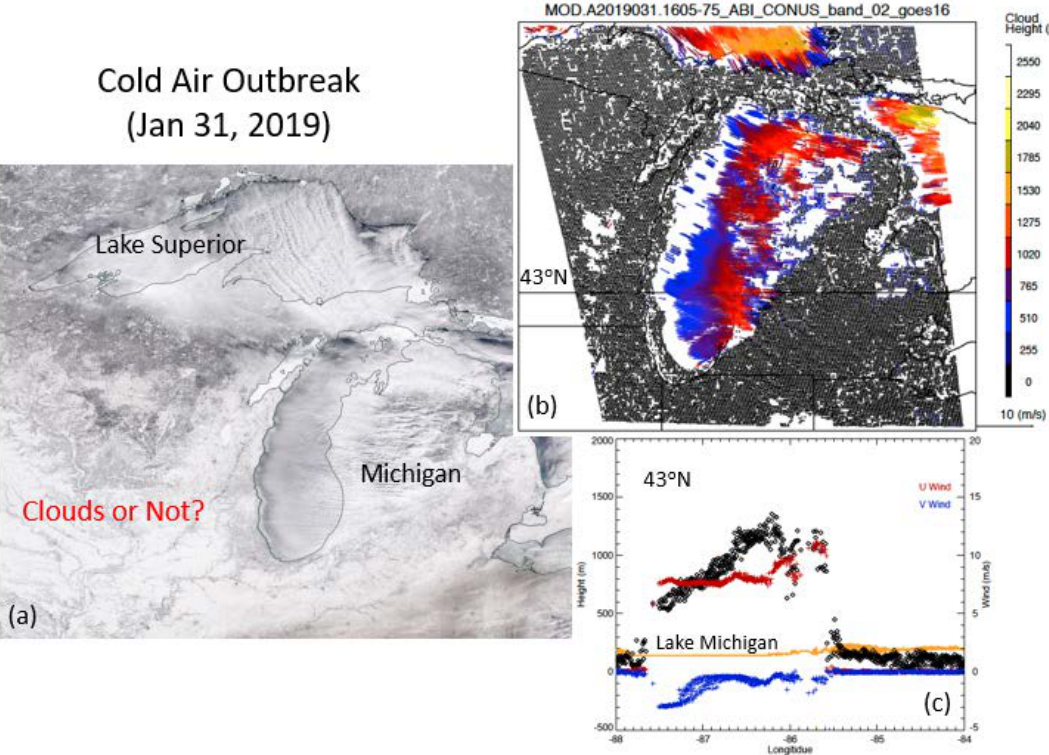
Figure 25. PBL cloud streets are readily seen from the cold air outbreak (CAO) event ( a ) over Lakes Superior and Michigan (shown at larger scale in Figure 24). The bottom-right panel ( c ) is a cross-section of the full set of retrievals ( b ) at 43 ◦ N latitude where terrain height is in orange and the stereo height is in black, showing PBL clouds rising in height from 400 m to 1100 m over Lake Michigan, as cold air blows over the relatively warmer water. Heavy snow often occurs downstream from the lake, as a result of the so-called ‘lake effect’.